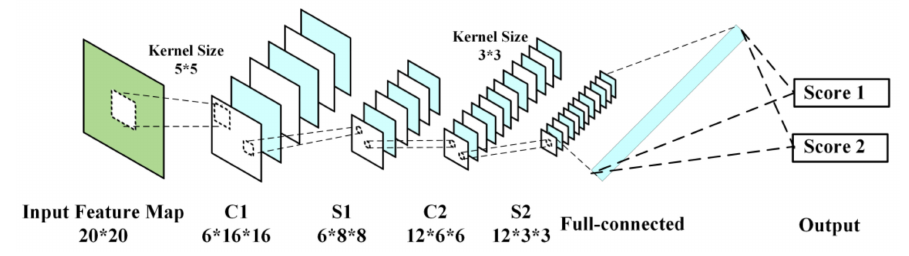
Figure 10. The architecture of the CNN in this paper.